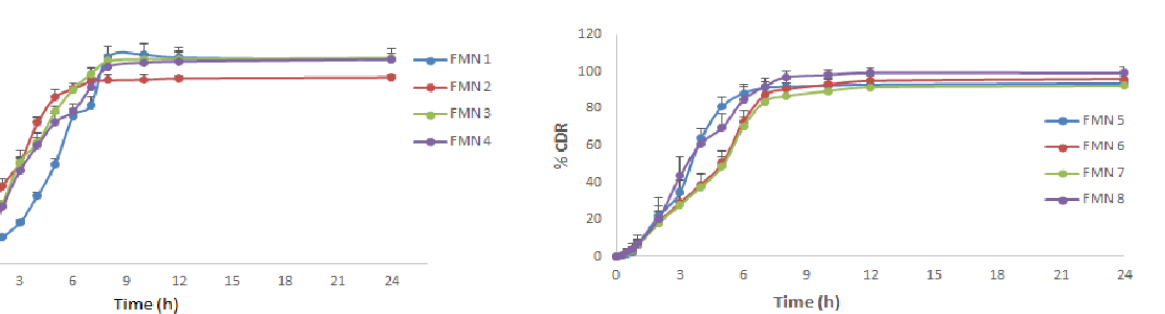
Figure 1(A) - In vitro release profile of formulation F1- F4 Figure 1(B) - In vitro release profile of formulation F5-F8.